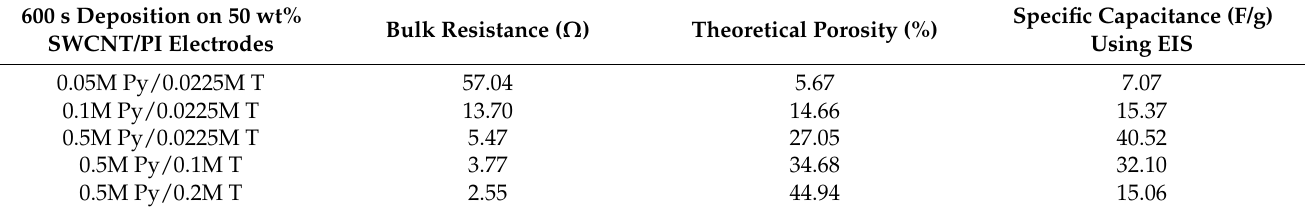
Figure 10. EIS: Nyquist plots showing the effect of Py concentration on electrodes with fixed dopant, modeled using equivalent Randle’s cell circuit with Warburg element. Table 3. Theoretical porosity and C p obtained using EIS with a modified version of Archie’s law.